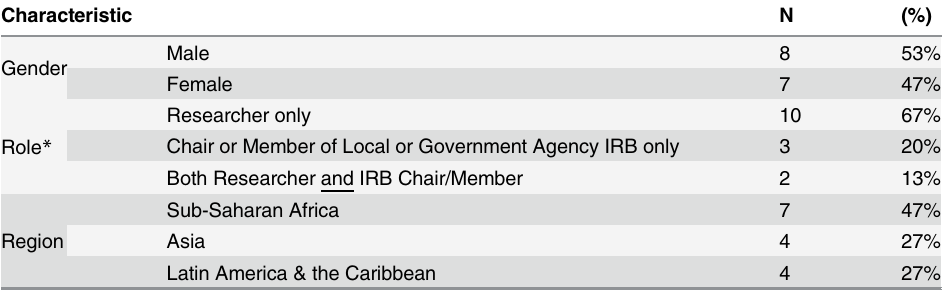
Table 1. Interviewee Demographic